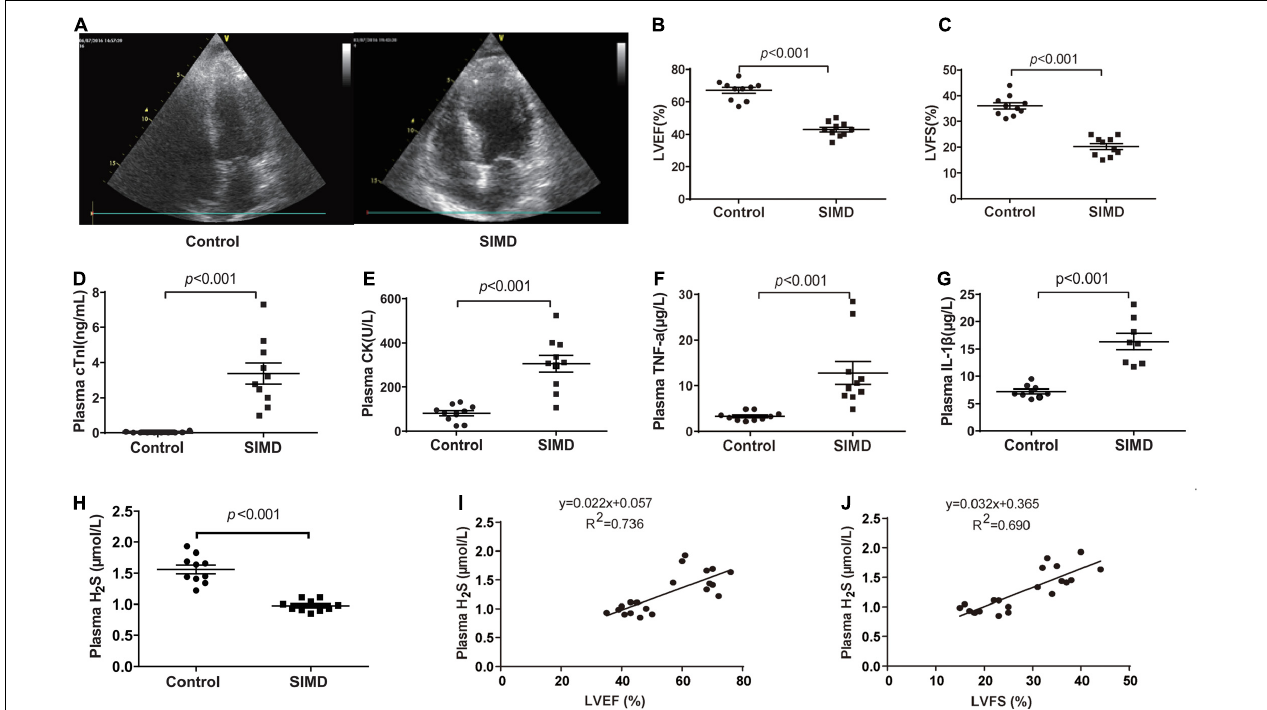
FIGURE 1 | Plasma H 2 S level decreased in SIMD patients: (A) Representative echocardiogram images from the Control group and the SIMD group. (B) The changes of left ventricular ejection fraction (LVEF). (C) The changes of left ventricular fractional shortening (LVFS). (D) cTnI levels in the plasma. (E) CK levels in the plasma. (F) TNF- α levels in the plasma. (G) IL-1 β levelsin the plasma. (H) H 2 S levels in the plasma. (I,J) Plasma H 2 S level is positively correlated with LVEF and LVFS. n = 10 in every group. Results are means ± SD. p < 0.05 was considered